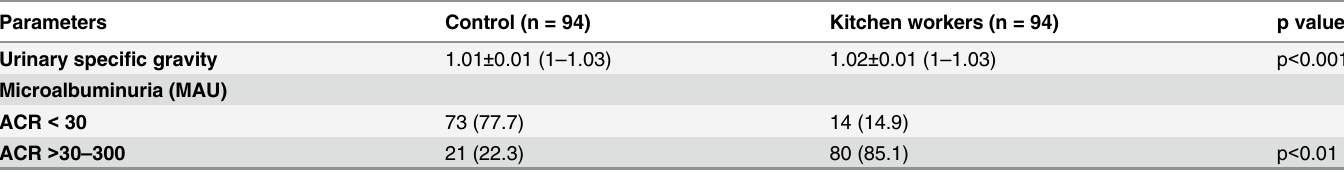
Table 2. Urinary specific gravity and albumin/creatinine ratio (ACR) among kitchen workers and controls.